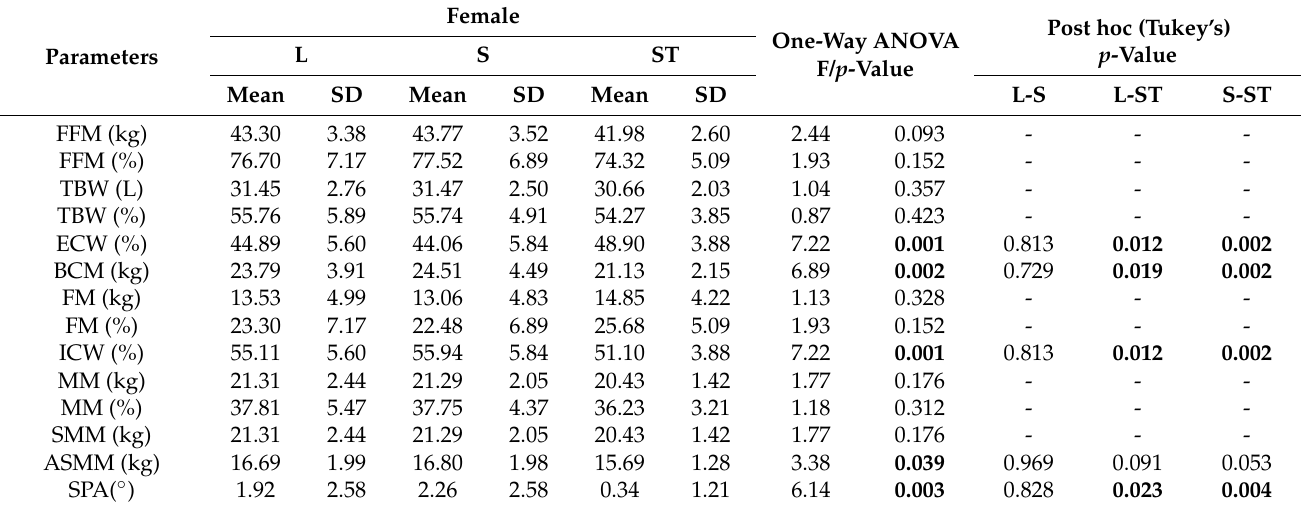
Table 4. Selected components of body composition among